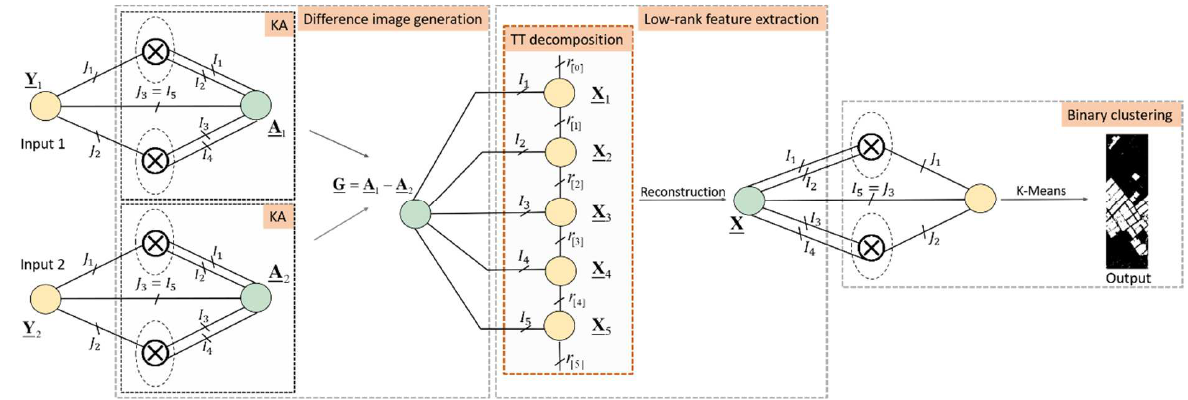
Figure 3. Framework of the proposed UTT for multitemporal HSI change detection.